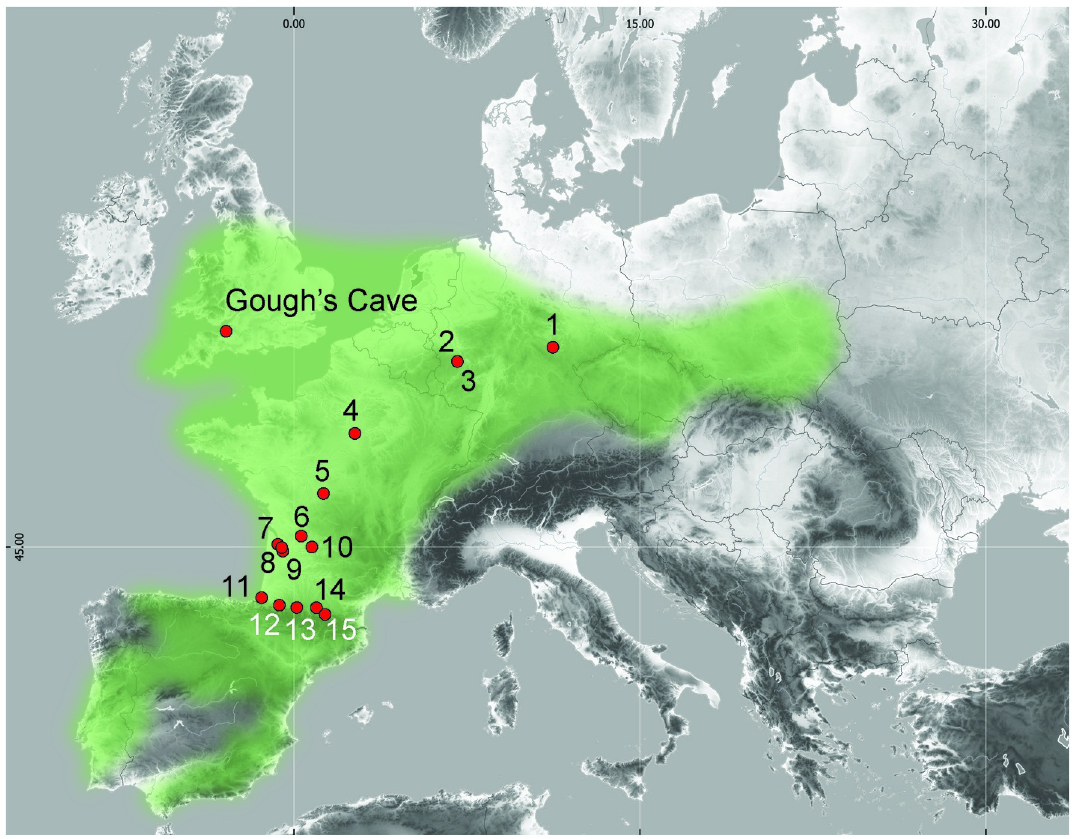
Fig 16. Location of Gough’s Cave and other Magdalenian sites with organic knapping tools in relation to the general distribution of Magdalenian sites (shown in green, after [90–93]and [94, Fig 8.3, p.439]). Key : 1. Oelknitz; 2. Andernach; 3. Go¨nnersdorf; 4 Pincevent; 5. La Garenne; 6. Rochereil; 7. Roc-de-Marcamps; 8. Saint-Germain-de-la-Rivi è re; 9. Moulin-Neuf; 10. Laugerie-Haute; 11. Isturitz; 12. Laa 2 Cave; 13. Labastide; 14. Enl è ne; 15. La Vache. Map made with Natural Earth. Free vector and raster map data @